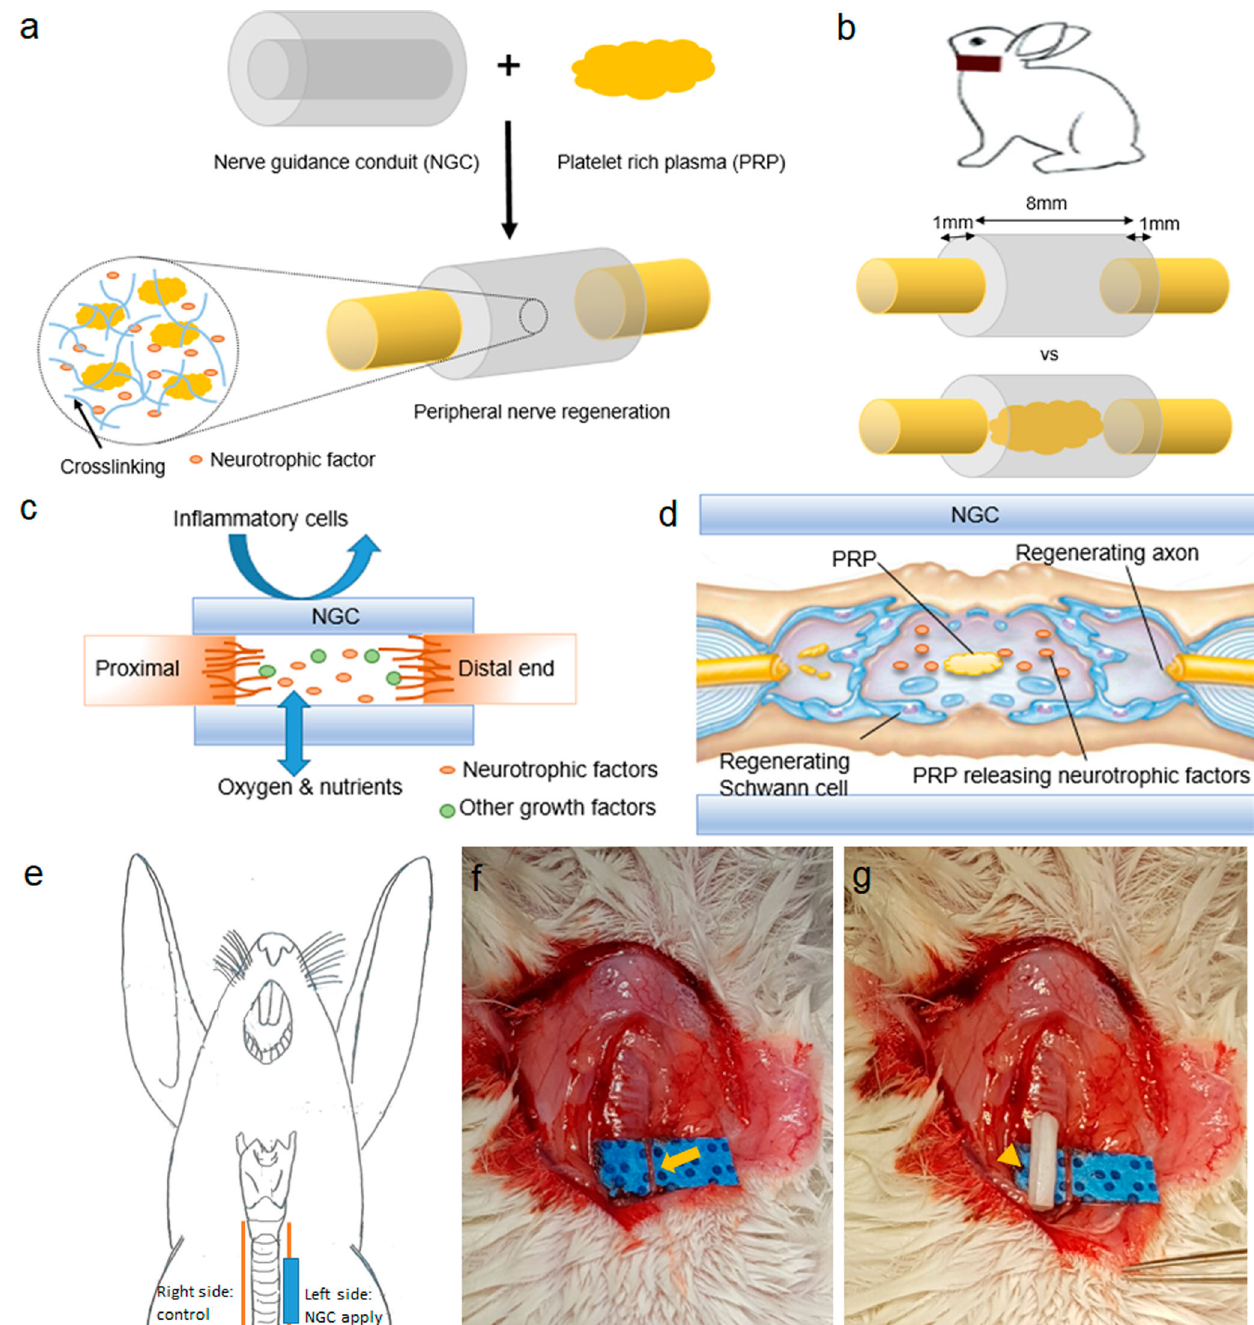
Fig. 1 Schematic illustrations of the NGC fi lled with PRP and application in animal model. a NGC was fi lled with PRP, and activated PRP released growth factors, including neurotrophic factors. b RLNs of rabbits were used to compare the ef fi cacies of un fi lled vs PRP- fi lled NGCs. c Asymmetrically porous (nano- and micropores on both surfaces) NGC membranes allow the penetration of oxygen and nutrients but prevent the transit of in fl ammatory cells. Neurotrophic factors and other growth factors released from activated PRP promote the axonal growth in the NGC. d PRP in NGCs stimulated the regeneration of Schwann cells and axons by releasing neurotrophic factors. e Interposition of an NGCs in our rabbit model of RLN injury. (Right RLN as control, Lt RLN: two different type of NGCs applied). f Photo of a left side RLN (arrow). g Photo of a PCL/Pluronic F127 NGC tube (arrowhead). NGC nerve guidance conduit, PRP platelet-rich plasma. RLN recurrent laryngeal